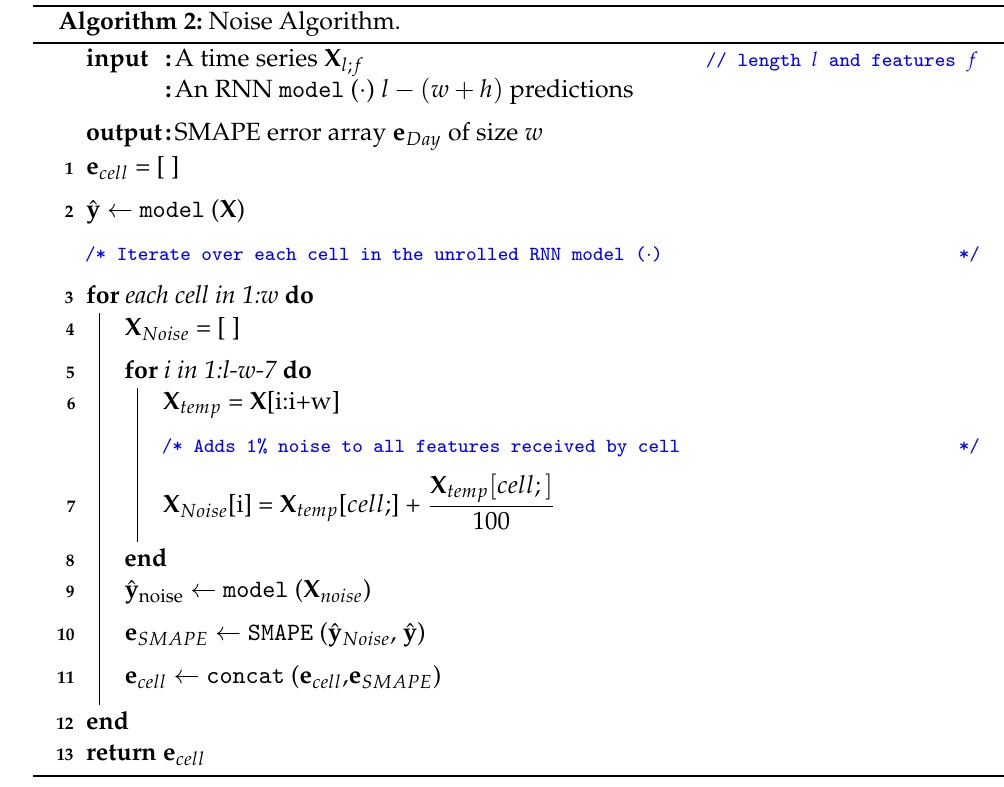
Algorithm 2: Noise Algorithm.